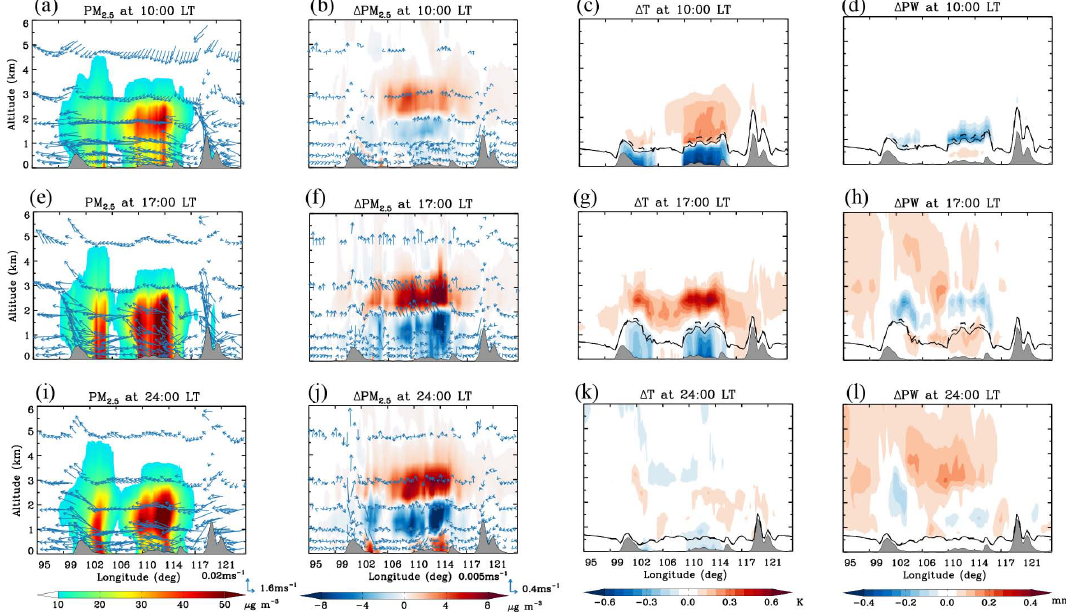
Fig. 4. Top row: vertical cross section of monthly averaged variables in October 2006 at 10:00LT for (a) PM 2 . 5 and u - w wind speed; (b) change of PM 2 . 5 , 1 PM 2 . 5 ; (c) change of temperature, 1T ; and (d) change of precipitable water, 1 PW. Second and third row are the same as the top row but at 17:00LT and 24:00LT, respectively. All variables are averaged along the vertical cross section centered at the latitude of 1 ◦ S (extends 2 grid points into and out). The terrain is also shown as gray shading in each panel. The difference of each variable ( 1V ) is defined as 1V = V Ra − V non-Ra . The OC/BC ratio is 10 in the simulation. Also overlaid in some panels are the PBLH simulated with the radiative effect of smoke aerosols (black line) and PBLH without the radiative effect of fires (dotted